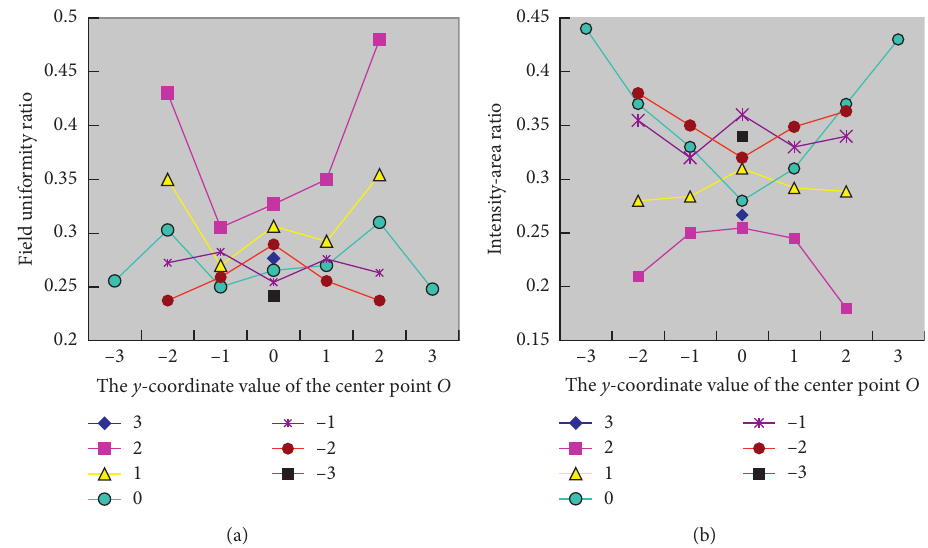
Figure 4: Variation of field uniformity (a) and intensity-area ratio (b) of samples at different positions ( x , y ) on the plane.